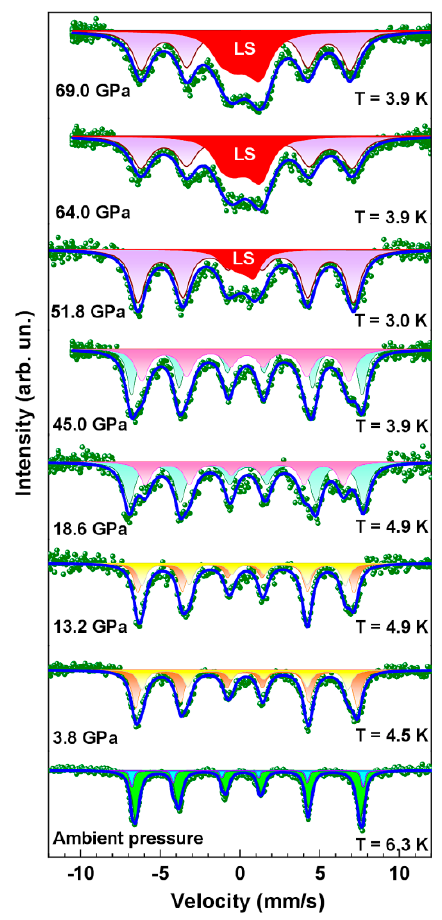
Figure 6. The low-temperature SMS spectra of Ba 3 NbFe 3 Si 2 O 14 at different pressures up to P = 69 GPa. Solid lines are calculated subspectra fitted the experimental data. At pressures 51.8, 64.0 and 69.0 GPa, the LS sign indicates the Mössbauer subspectrum corresponding to iron ions in the low-spin state.